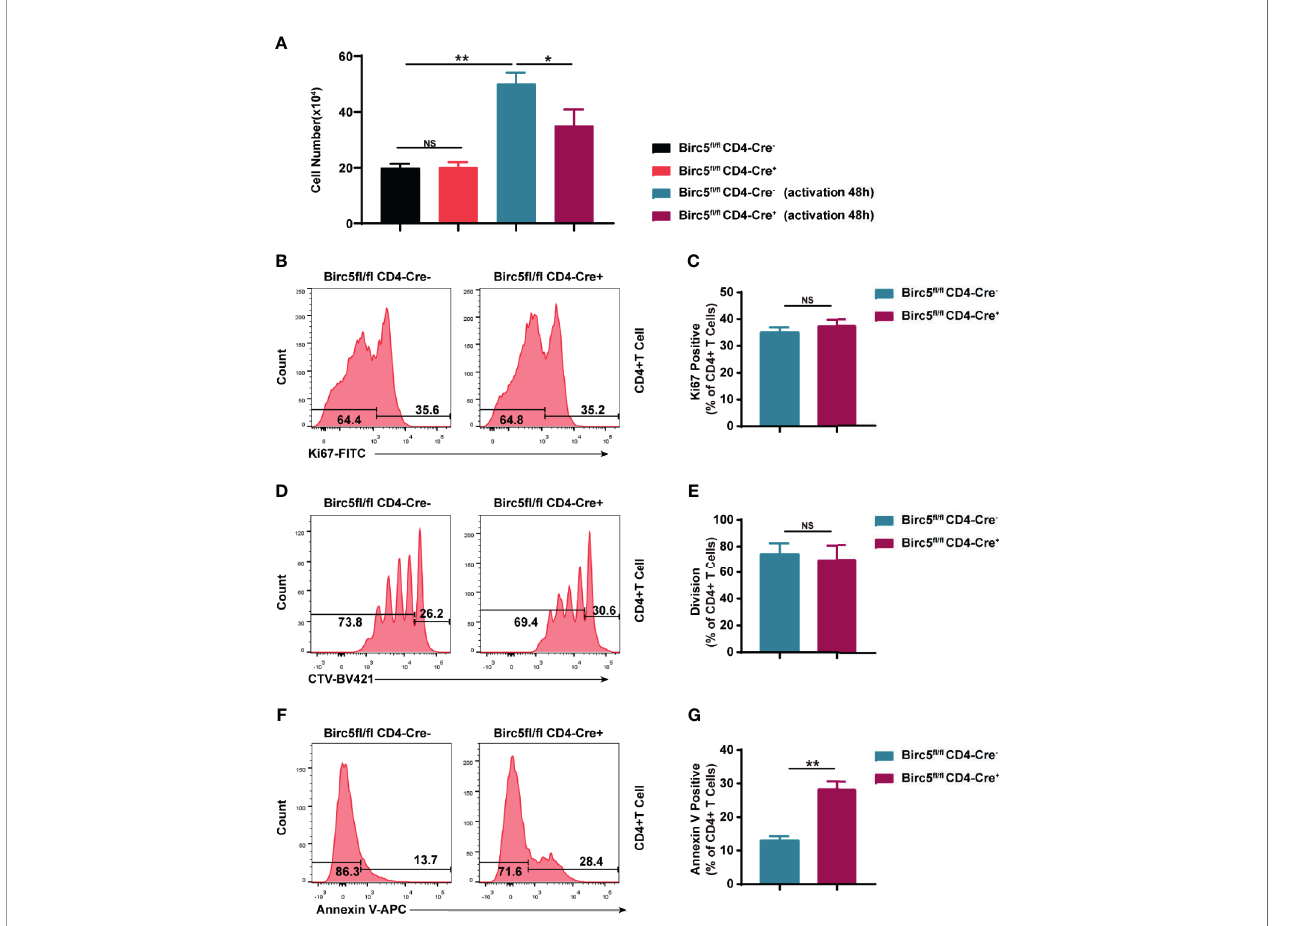
FIGURE 4 | In vitro knockout of Birc5 in T cells causes a decrease in the number of T cells through apoptosis and not by interfering with proliferation. (A) The number of CD4 + T cells isolated from the spleen of WT or Birc5 -/- mice before and after activation in vitro . Representative histogram plots of (B) Ki67, (D) CTV and (F) Annexin V positive cells. (C, E, G) Bar graphs of the percentage of parent gated T cells isolated from the spleen of WT or Birc5 -/- mice at 6-8 weeks of age following stimulation with anti-CD3/CD28 for 48h in vitro . Data are representative of 4 independent experiments (n = 3 mice per group). Data is presented as the mean ± SD. * p < 0.05, ** p < 0.01, ns, not statistically signi fi